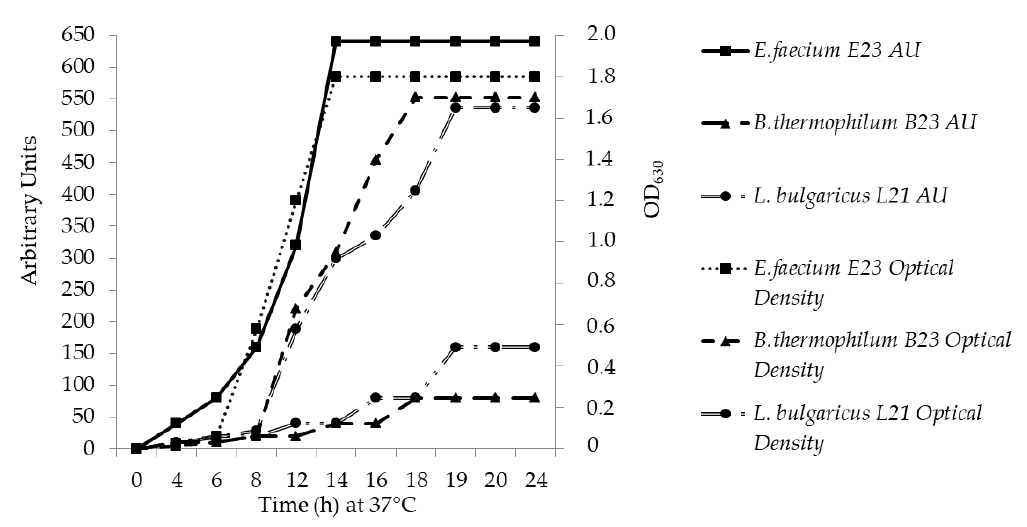
Table 1. Antibacterial activity of the five best bacteriocin producer strains detected in cell-free supernatant fluid by agar well diffusion assay.